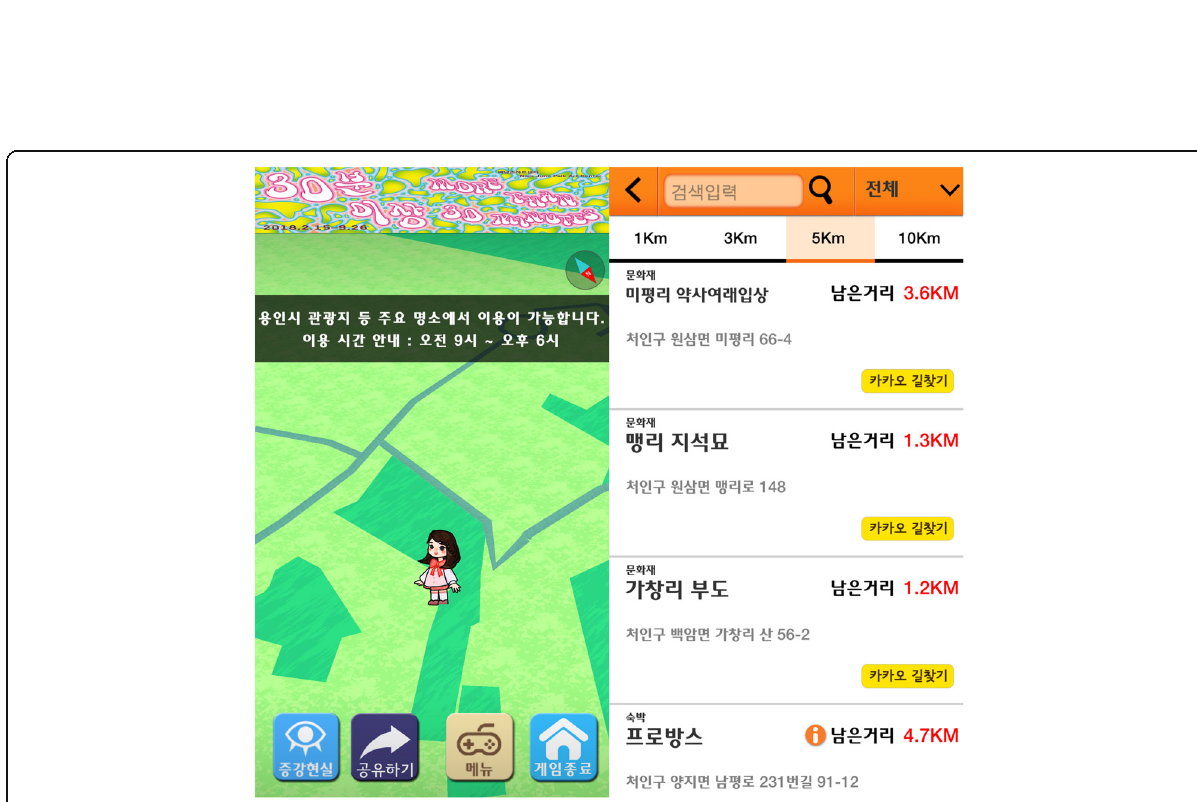
Fig. 5 Example of utilizing location-based technology. An example of utilizing the location-based technology of the Kkongalmon